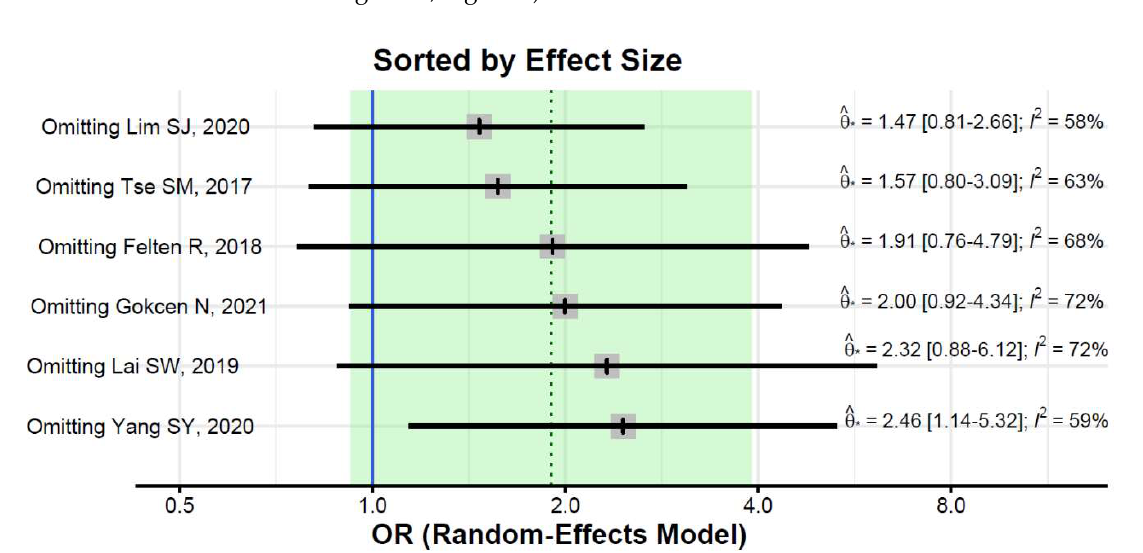
Figure 4. Funnel plot for publication bias [31–36].